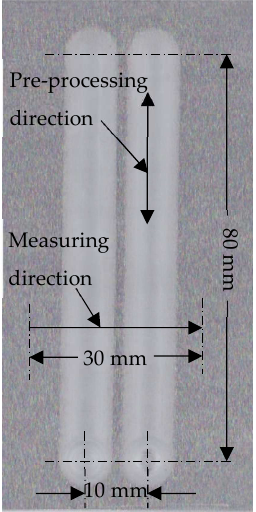
Figure 13. The workpiece after pre-processing.